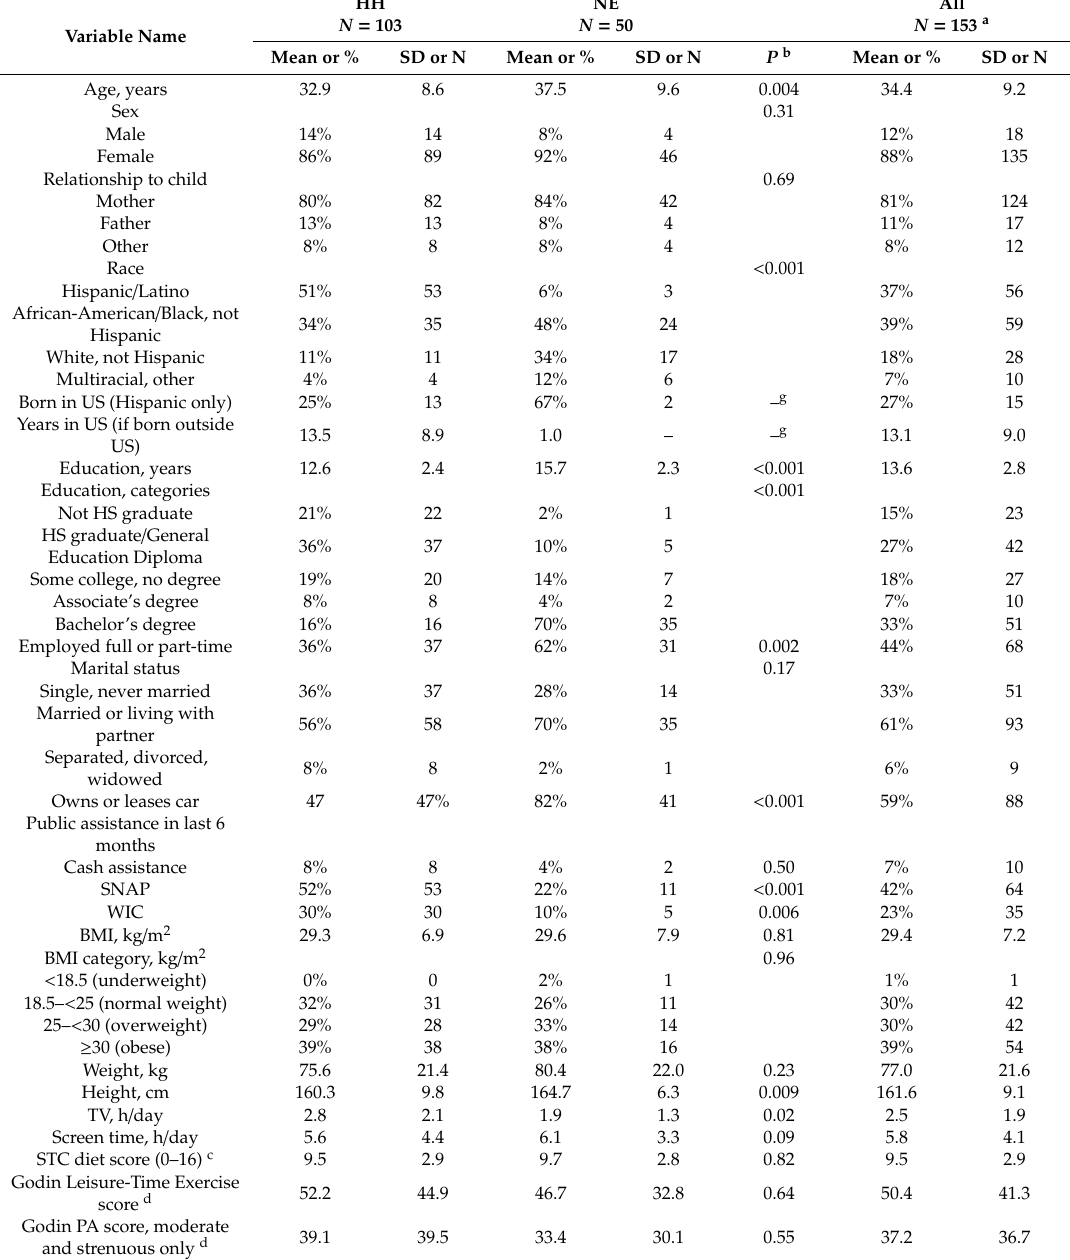
Table 2. Parents’ characteristics at baseline, by